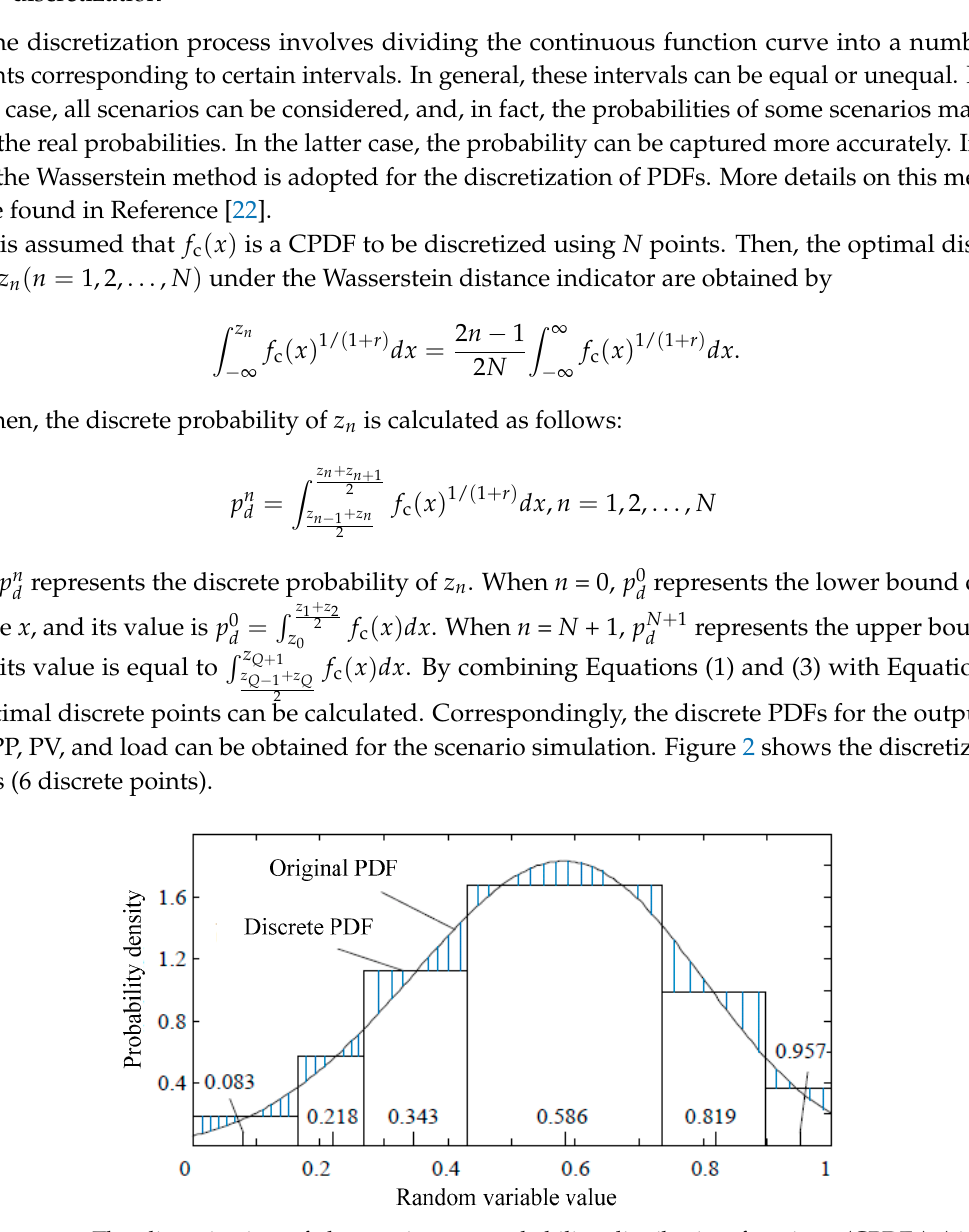
Figure 2. The discretization of the continuous probability distribution functions (CPDFs) (six discrete points).